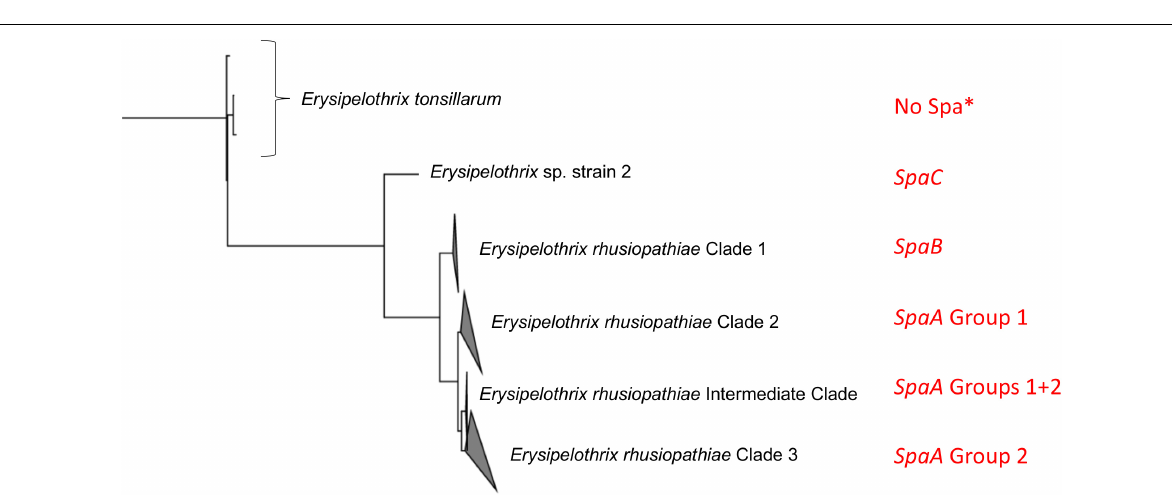
FIGURE 4 | Discriminatory amino acid positions within the immunoprotective domain of the SpaA protein of Erysipelothrix rhusiopathiae. Amino acid (AA) variant positions with respect to the Fujisawa reference sequence are listed in the top row, with the amino acid found in the reference sequence shown in the second row. The phylogenetic tree shown to the left shows the relatedness among the SpaA sequence variants. Variants in each group are shown in blue boxes, with the AA change indicated.